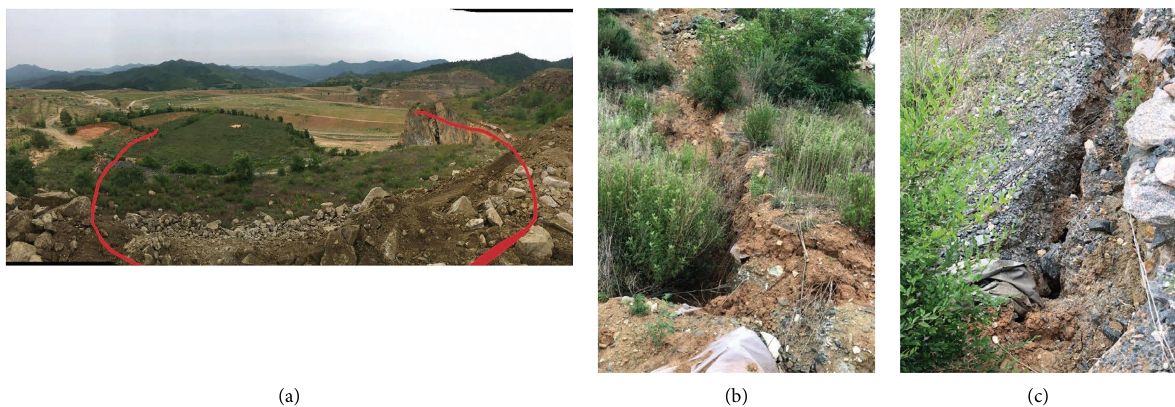
Figure 6: Te present situation of handling results. (a) Surface subsidence. (b) Surface cracks. (c) Surface